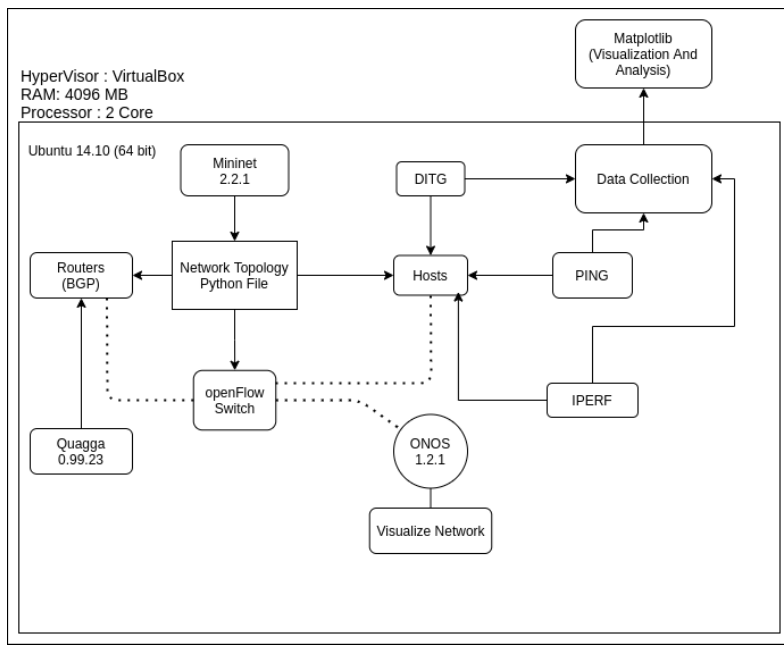
Figure 4. System setup simulation